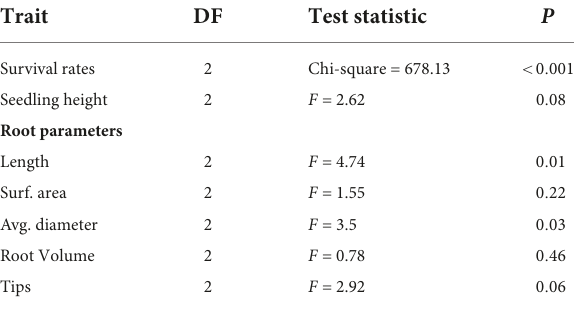
TABLE 2 The results of tests (Wald for survival rates (S) and F for other traits) testing differences between the experimental variants (N, F, SP) for tested traits.